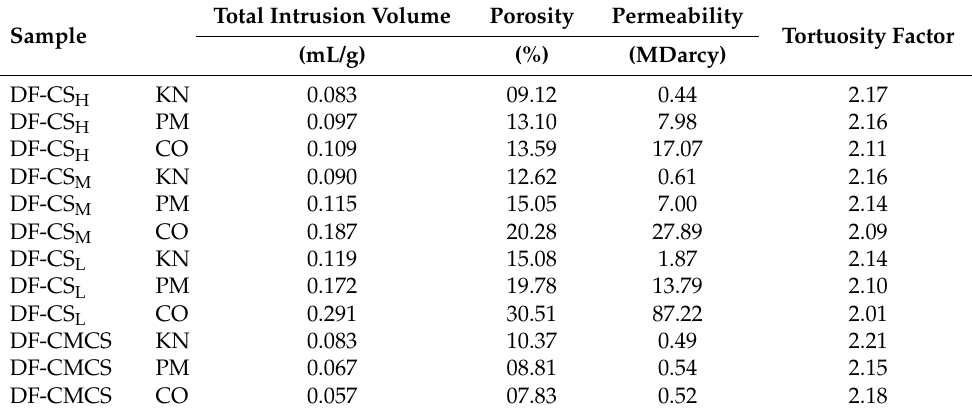
Figure 2. Pore mean diameter distributions of ( A ) DF-CS H , ( B ) DF-CS M , ( C ) DF-CS L and ( D ) DF- CMCS. In all cases: KN ( ∆ ), PM ( ● ) and CO systems ( □ ). Table 2. Internal structure parameters of DF-CS